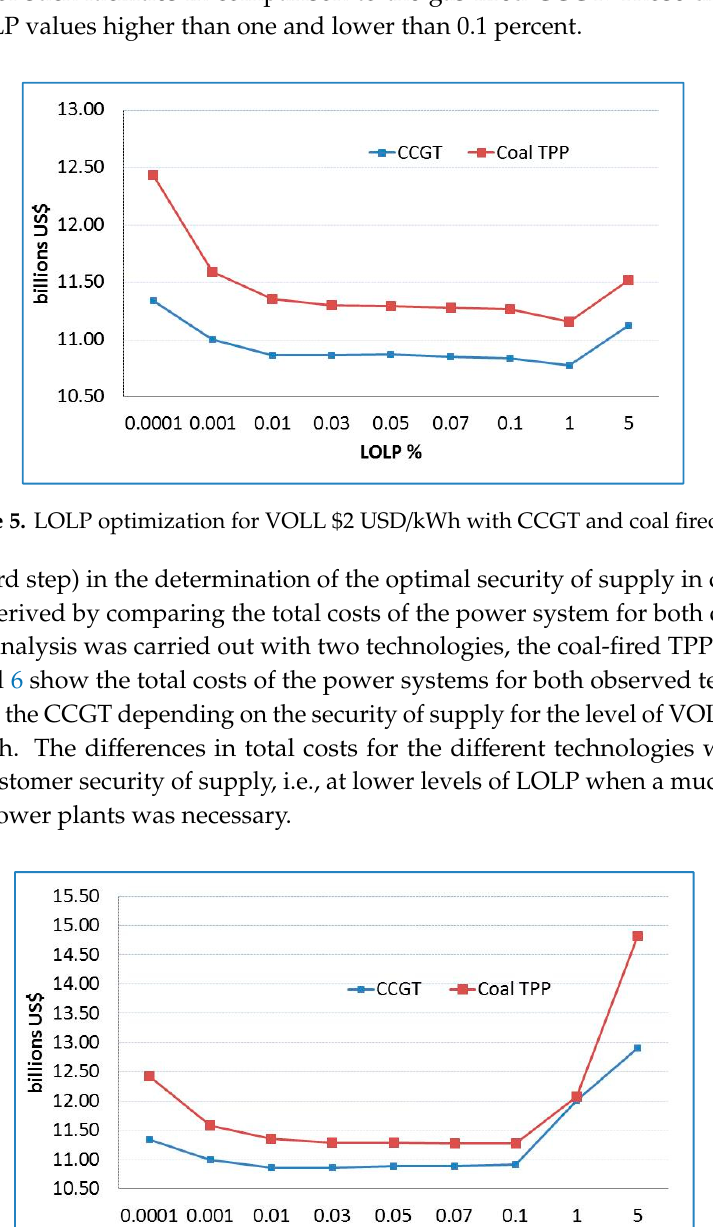
Figure 5. LOLP optimization for VOLL $2 USD/kWh with CCGT and coal fired TPP.